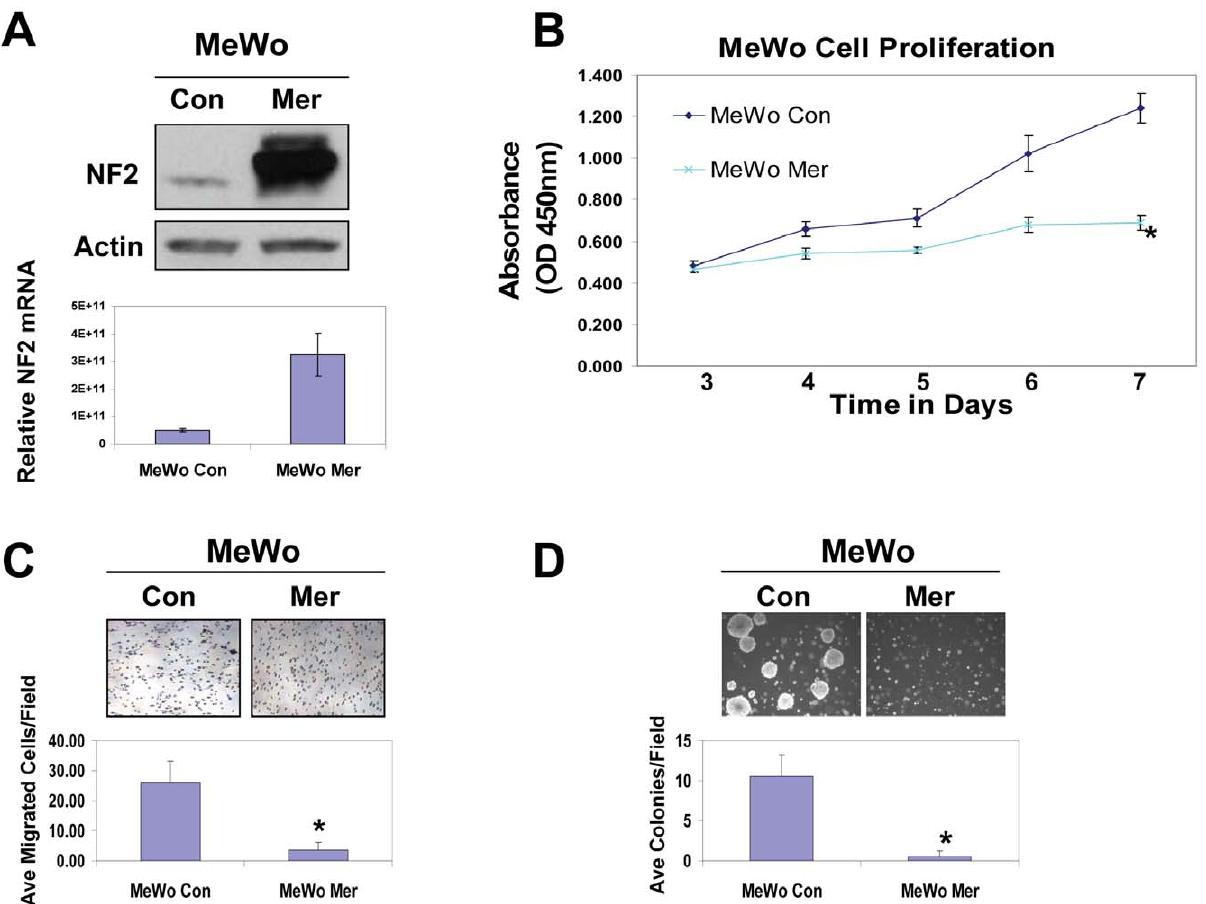
Figure 4. Increased merlin levels inhibit proliferation, migration and anchorage-independent growth of MeWo human melanoma cells. A , Top panel: Western blot of MeWo cells overexpressing merlin (MeWo Mer) or transduced with an empty vector control (MeWo Con). 50 m g of protein was loaded into each lane. Actin was included as a loading control. Bottom Panel: NF2 mRNA levels in the transduced MeWo cells were determined by quantitative Real-time RT-PCR. B , WST-1 proliferation assay of the cells transduced with merlin or the empty vector control. C , Transwell migration assay demonstrates that merlin significantly reduces the motility of MeWo cells. Bars represent the mean numbers of cells migrated through transwells in 15 randomly selected 200X microscopic fields. *denotes a p -value , 0.01. D , MeWo cells transduced with merlin display an impaired ability to form colonies in soft agar. Graph represents the mean number of colonies in 15 randomly selected microscopic fields. *denotes p -value ,